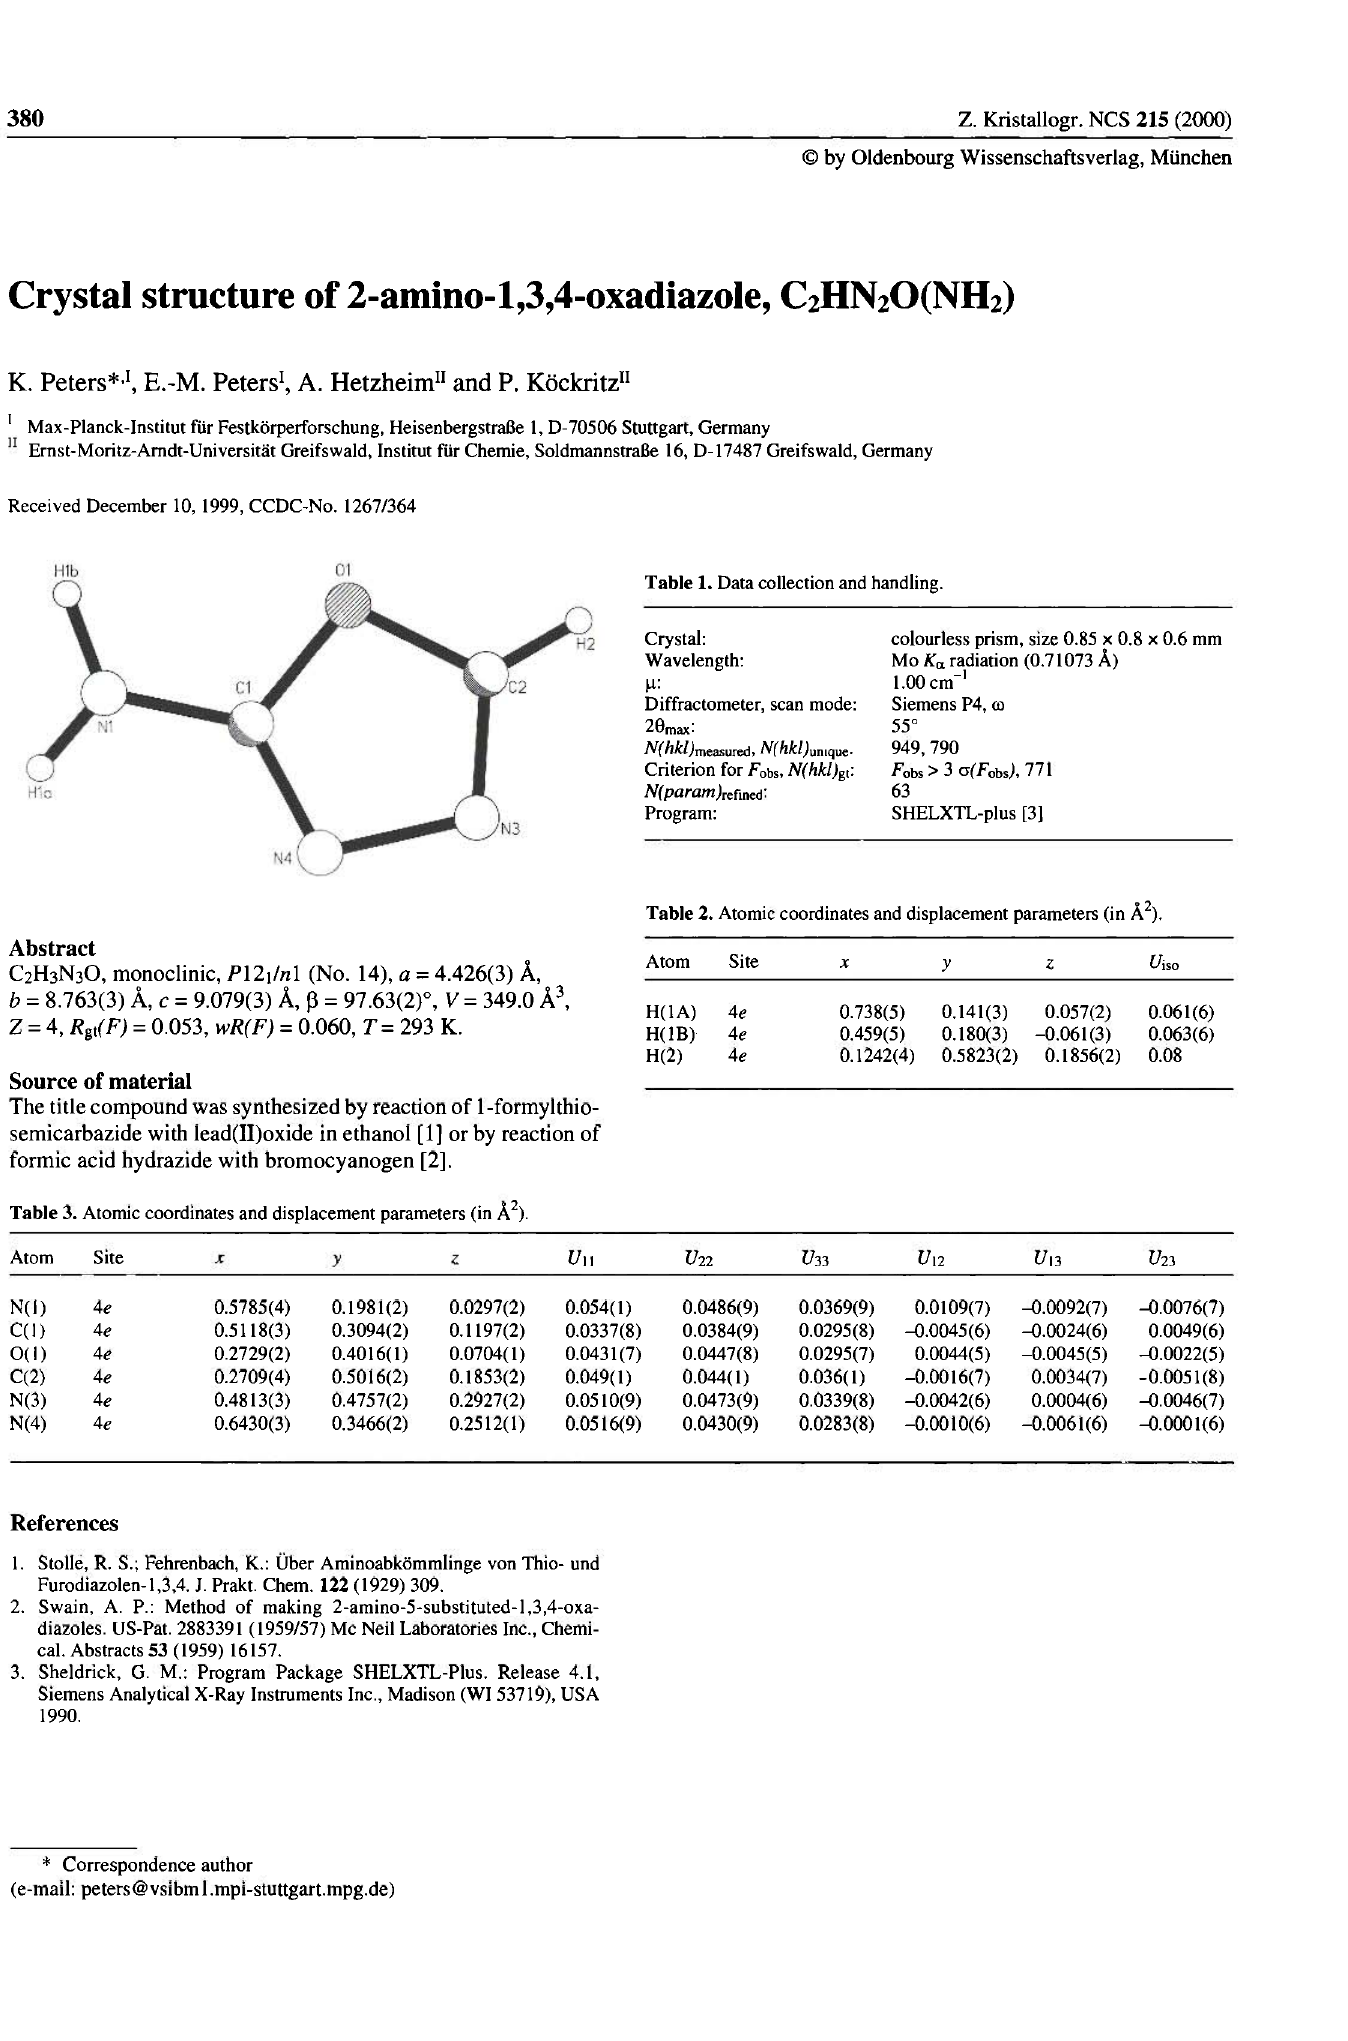
Table 3. Atomic coordinates and displacement parameters (in Ä 2 ).